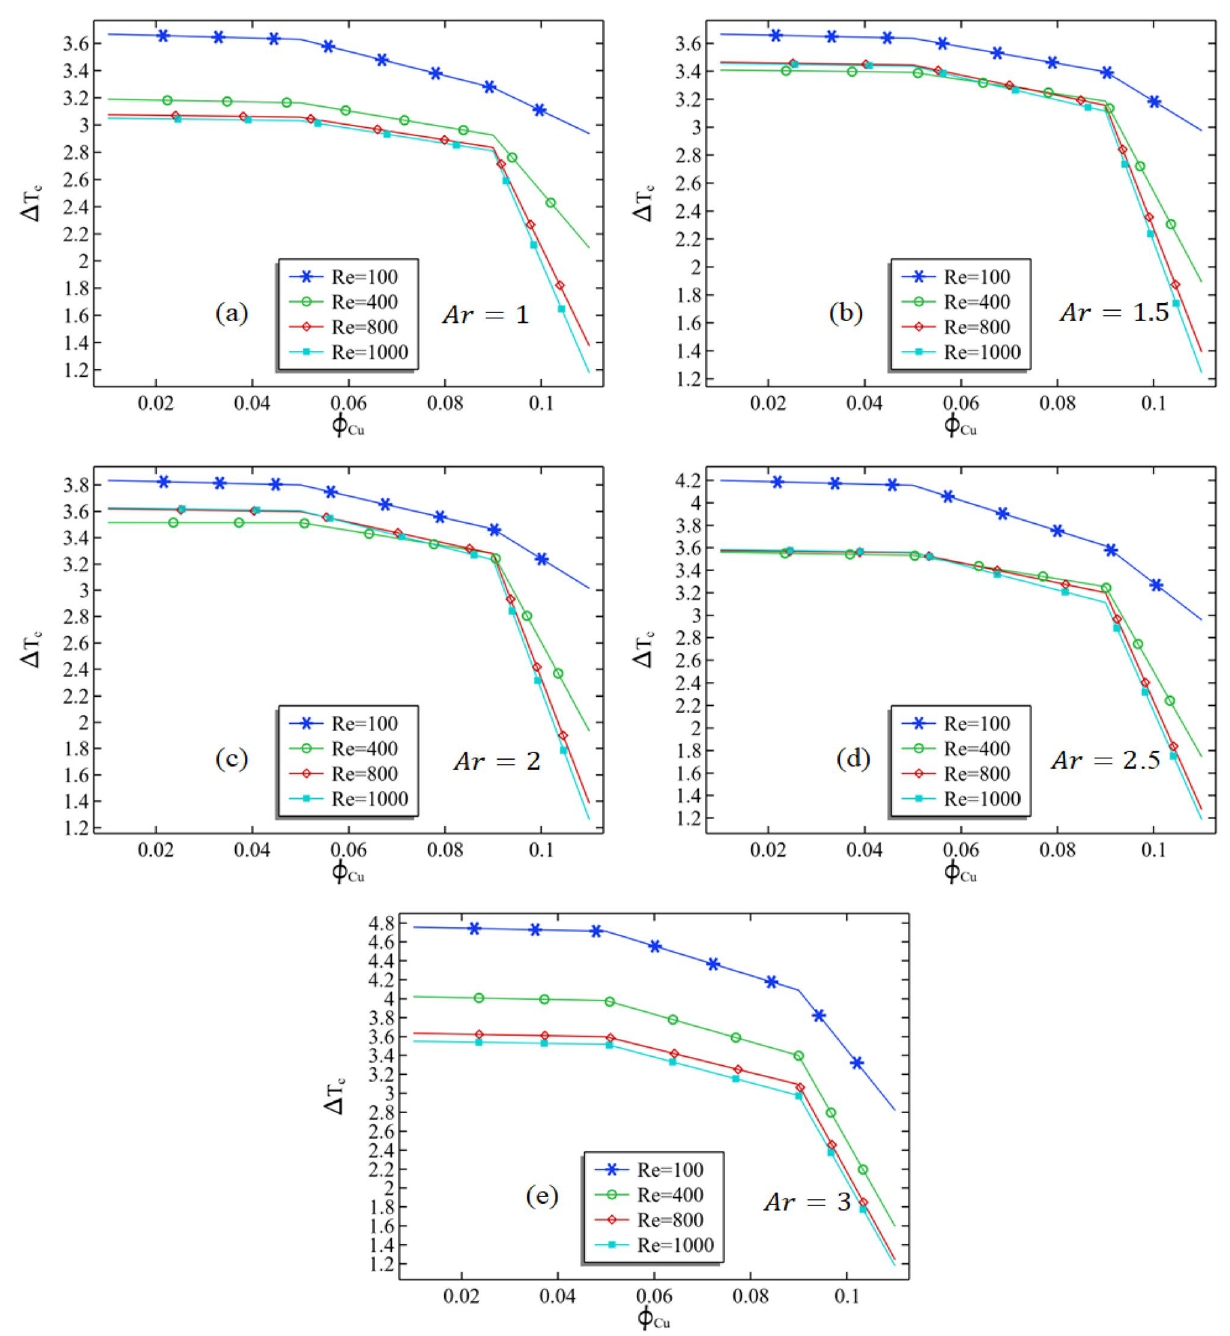
Figure 7. The percentage change in the temperature due to the cold temperature against the increase in the volume fraction of copper at the center of the